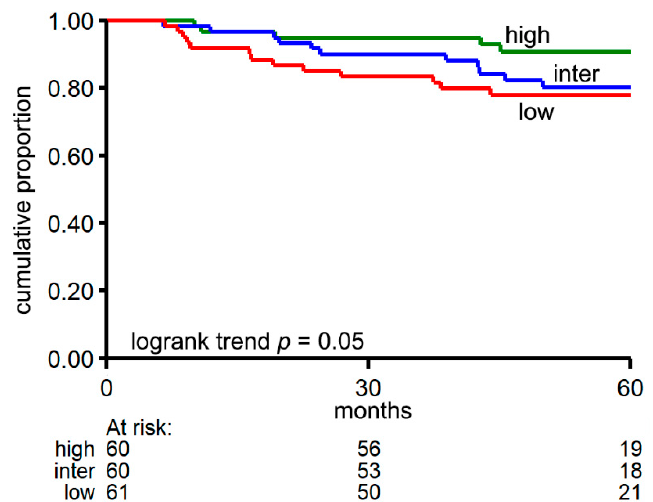
Table 3. Association of presence/absence of circRNAs with relapse status, tumor stage, CMS and MSI. Figure 5. Kaplan–Meier survival curves of disease free survival in which patients were grouped in 3 equal quantiles based on their diversity in circRNA expression. The red line represents the quantile with the lowest diversity in circRNAs, the blue line represents the quantile with intermediate diversity in circRNAs and the green line represents the quantile with the highest diversity in circRNAs.